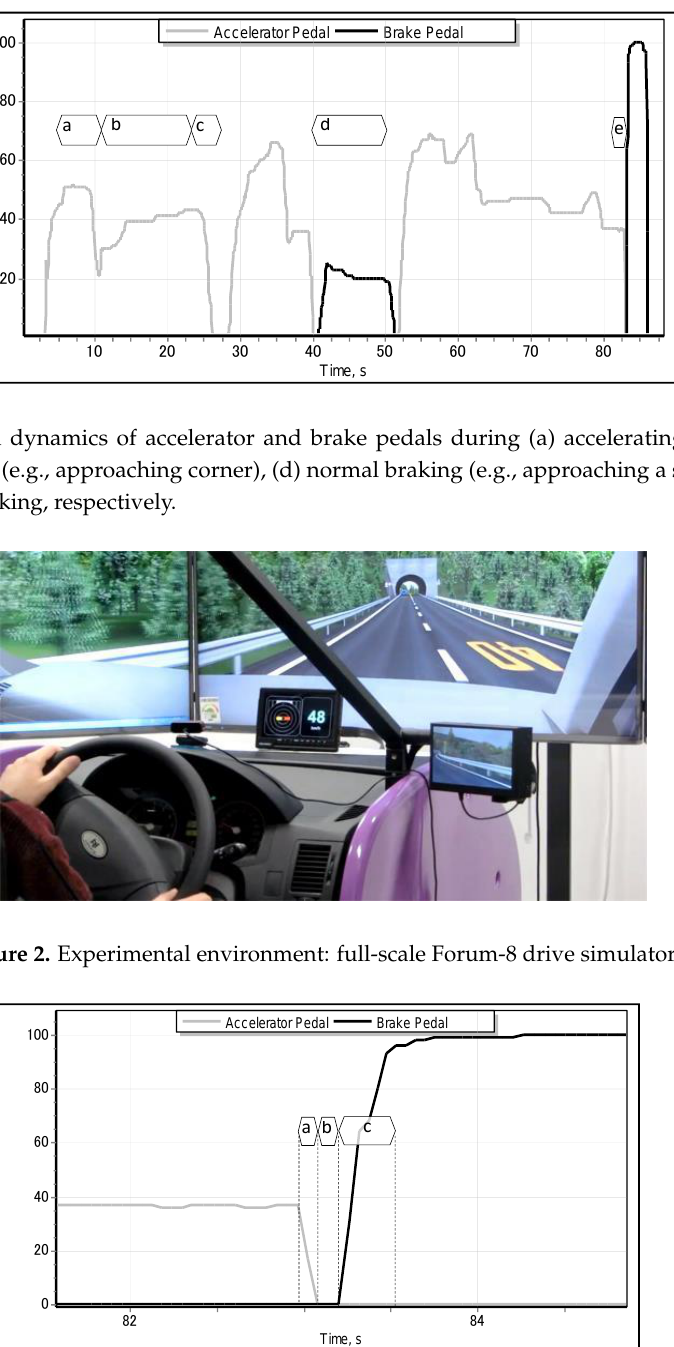
Figure 3. Typical dynamics of accelerator and brake pedals during emergency braking. The braking behavior of the driver could be decomposed into the following three actions: lifting the accelerator (a), moving the right leg from accelerator to the brake pedal (b), and pressing the brake pedal to its (almost) maximum position (c). Depending on physical and cognitive condition of the driver, the corresponding time lags of these actions might significantly vary.